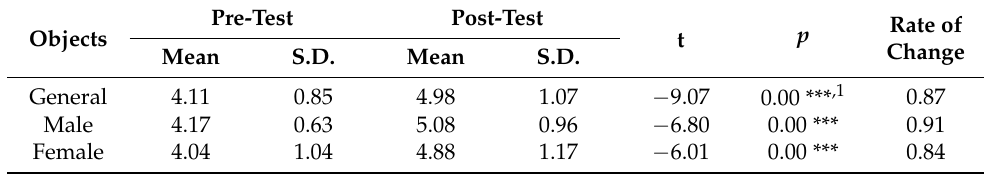
Table 2. Changes in ROS scores before and after viewing the urban landscape forest